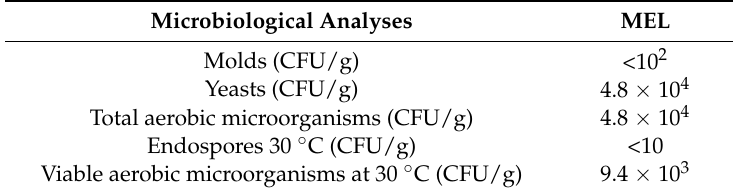
Table 1. Microbiological analyses of the melanoidin beverage (MEL) prior to its administration to